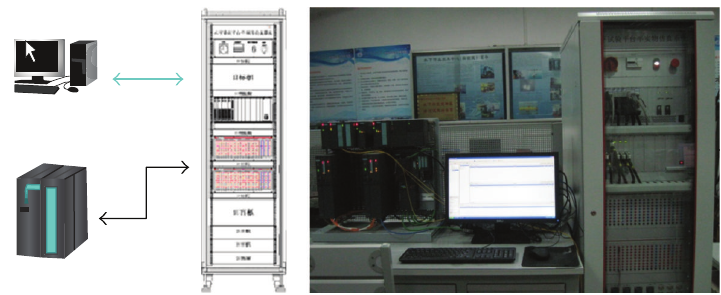
Figure 2: Hardware-in-loop simulation system.